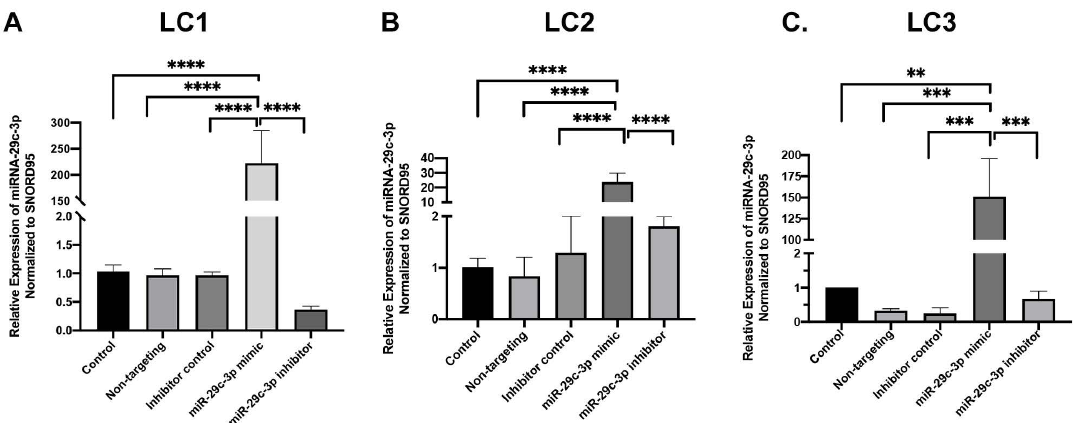
Figure 3. miRNA-29c-3p transfection efficiency in LC cells. Primary human LC cells were transfected with miR-29c-3p mimic (10 nm), miR-29c-3p inhibitor (10 nm), or non-targeting controls and transfection efficiency as determined by qPCR. SNORD95 was used as a normalizing control. ( A – C ) miRNA-29c-3p expression in each LC cell strain (LC1—donor 56 years old, LC2—donor 70 years old, and LC3—donor 74 years old). Error bars show the standard deviation (SD). One-way